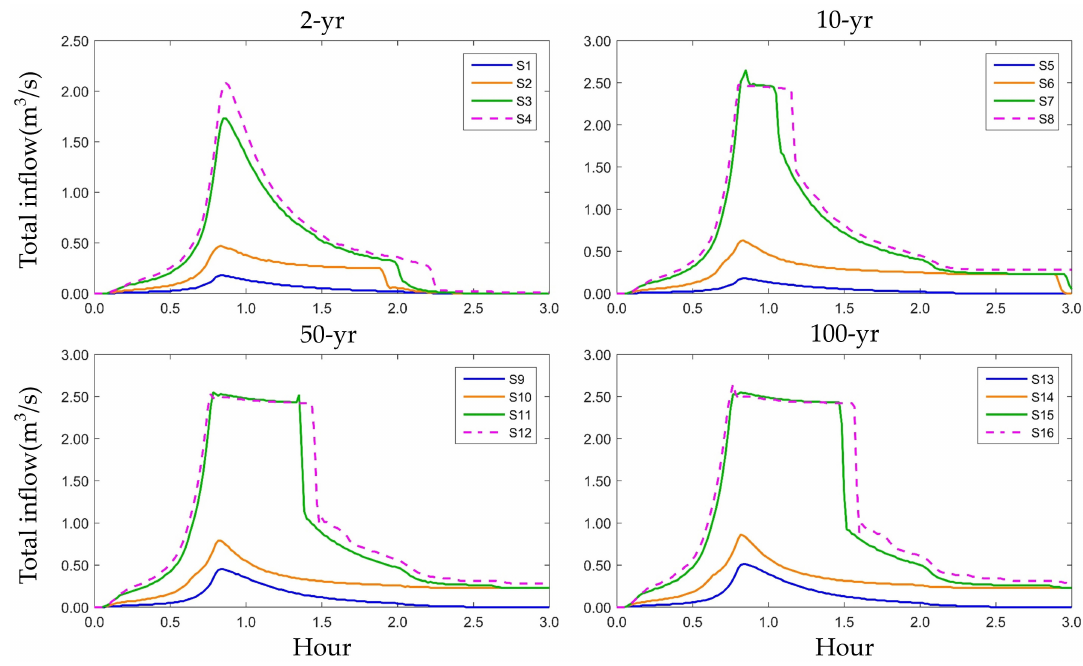
Figure 13. Total inflow hydrographs of outfall 3Y80 in the main district for the 16